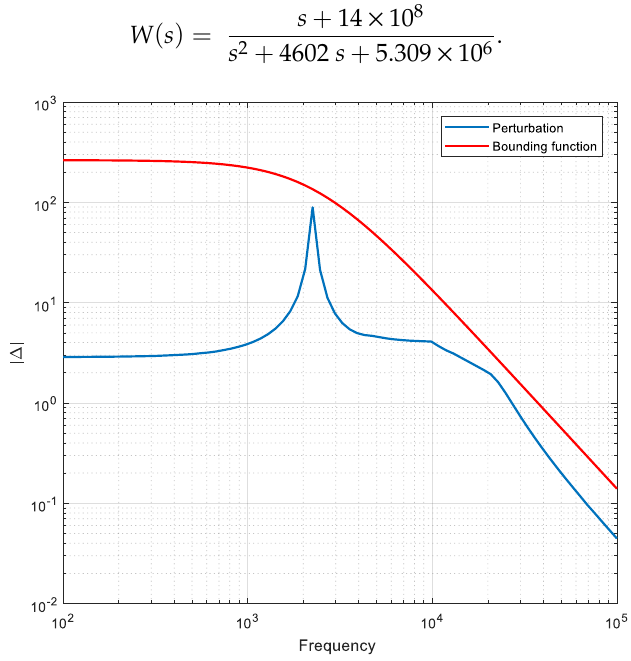
Figure 8. Bounding Figure 8. Bounding function.